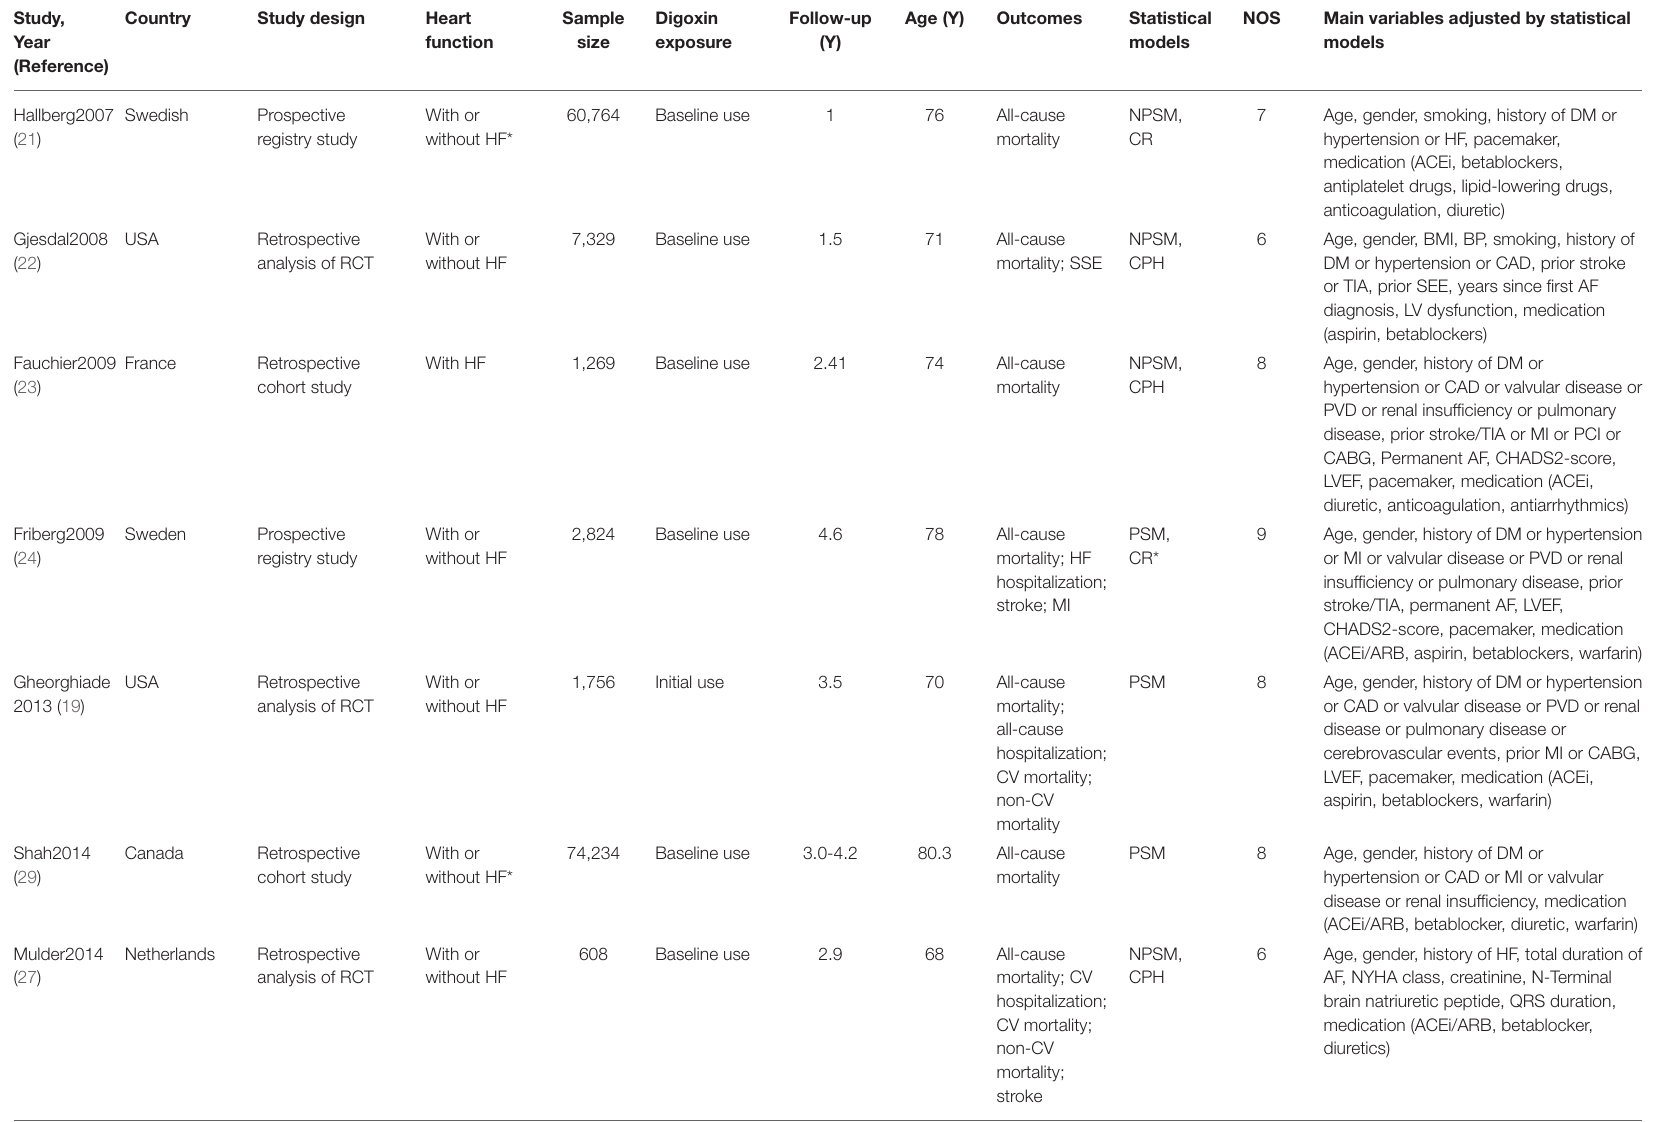
TABLE 1 | Characteristics of the included